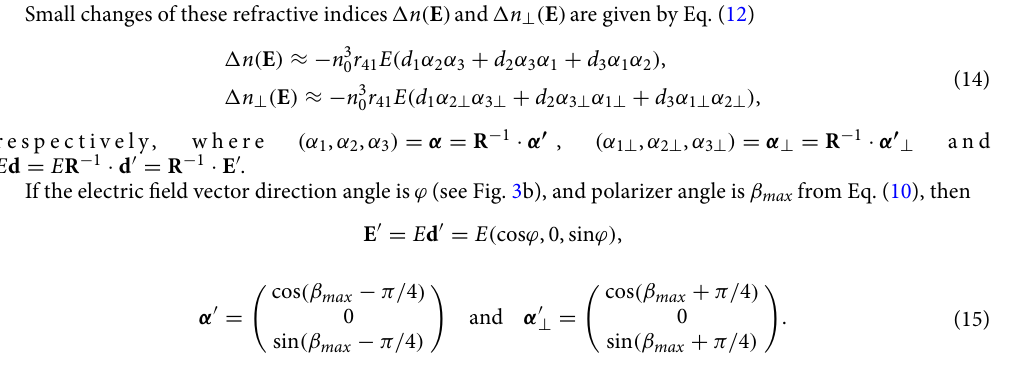
The light in a biased electrooptic material propagates in a form of two perpendicular linearly polarized modes with polarizations described by unit vectors α the elliptical cut from Fig. 3 and with refractive indices n ( E ) and n Small changes of these refractive indices � n ( E ) and � n